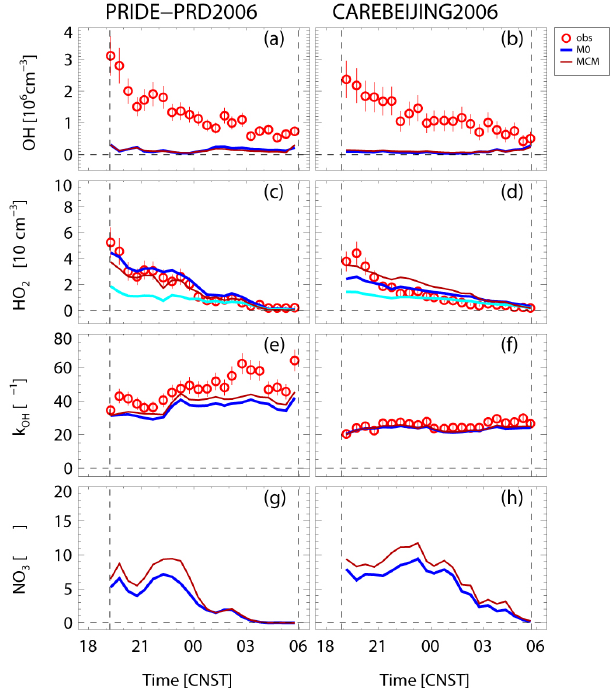
Figure 3. Model–measurement comparison of mean nighttime vari- ations of OH, HO ∗ , and k OH for PRIDE-PRD2006 and CAREBEI- 2 JING2006. The error bars attached to the observed data points de- note the combined uncertainty from precision and accuracy (1 σ ). In addition, model-simulated concentrations of HO 2 (M0, cyan lines in (c) and (d) ) and NO 3 ( (g) and (h) ) are